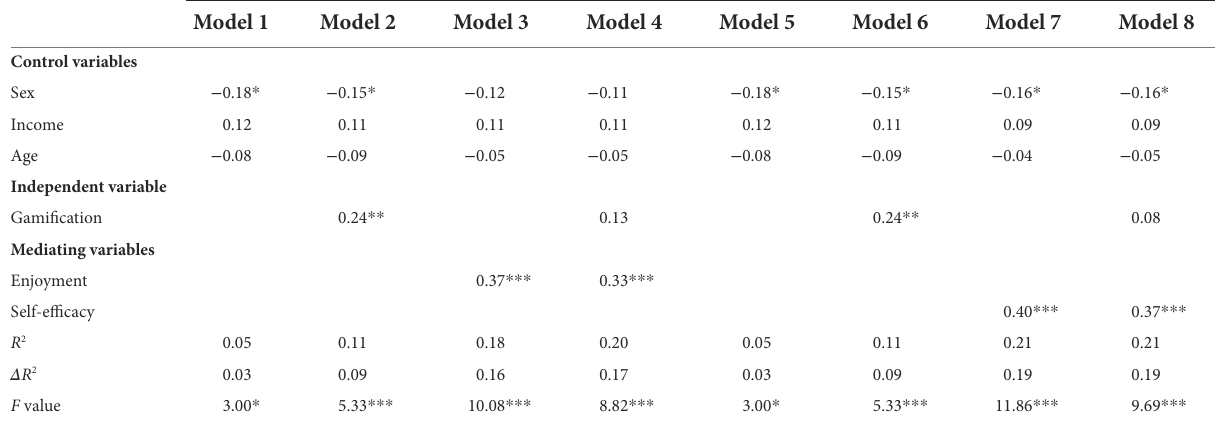
N = 187. * p < 0.05; ** p < 0.01. TABLE 3 Mediating effect